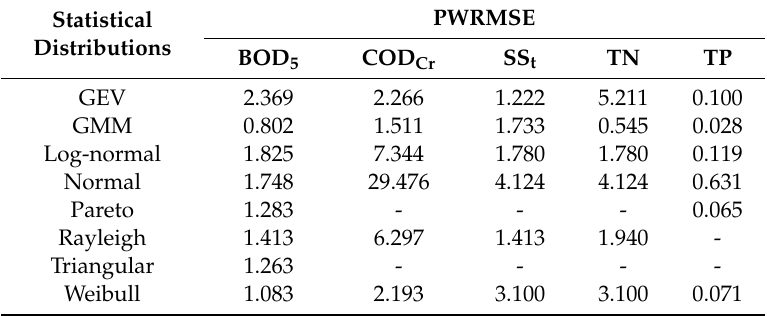
Table 3. The results of the peak-weighted root mean square (PWRMSE) analysis for tested pollutants